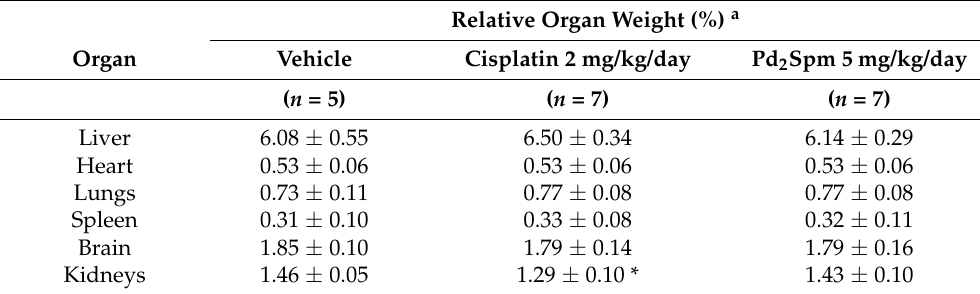
Table 3. Relative organ weight after treatment with either Pd 2 Spm, cisplatin or